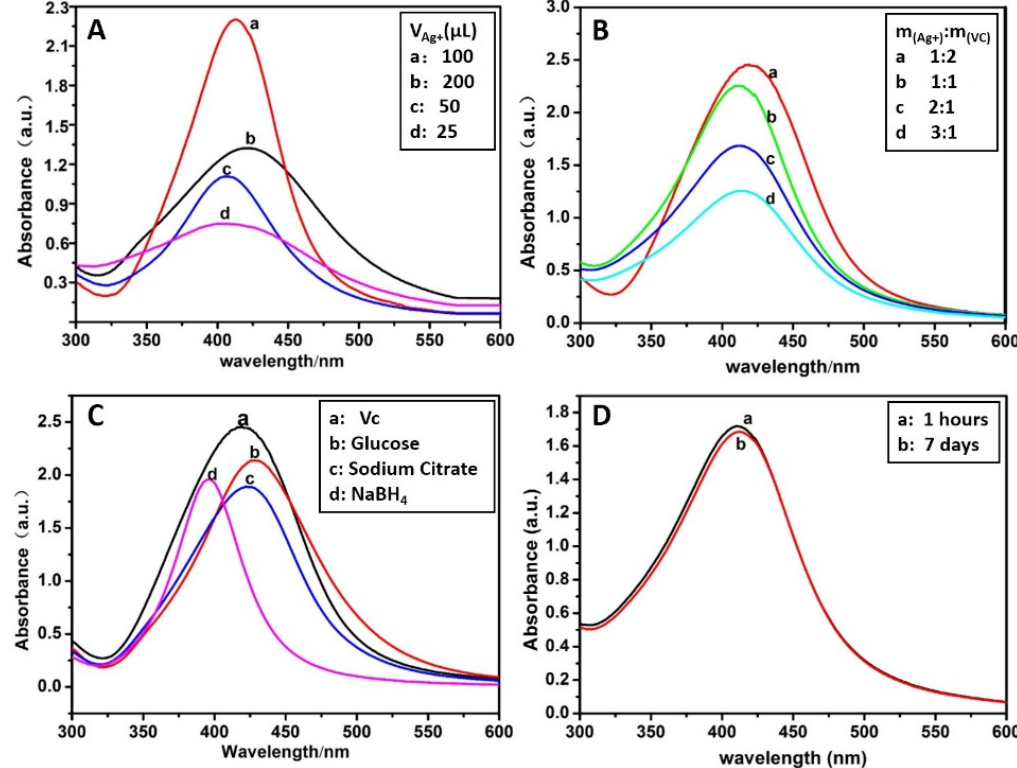
Figure 2. UV–VIS spectra of CMS/AgNPs: ( A ) Different volumes of Tollens’ reagent (0.1 M), ( B ) different proportion of VC, ( C ) different reducing agents, and ( D ) reduction stability of Vc.